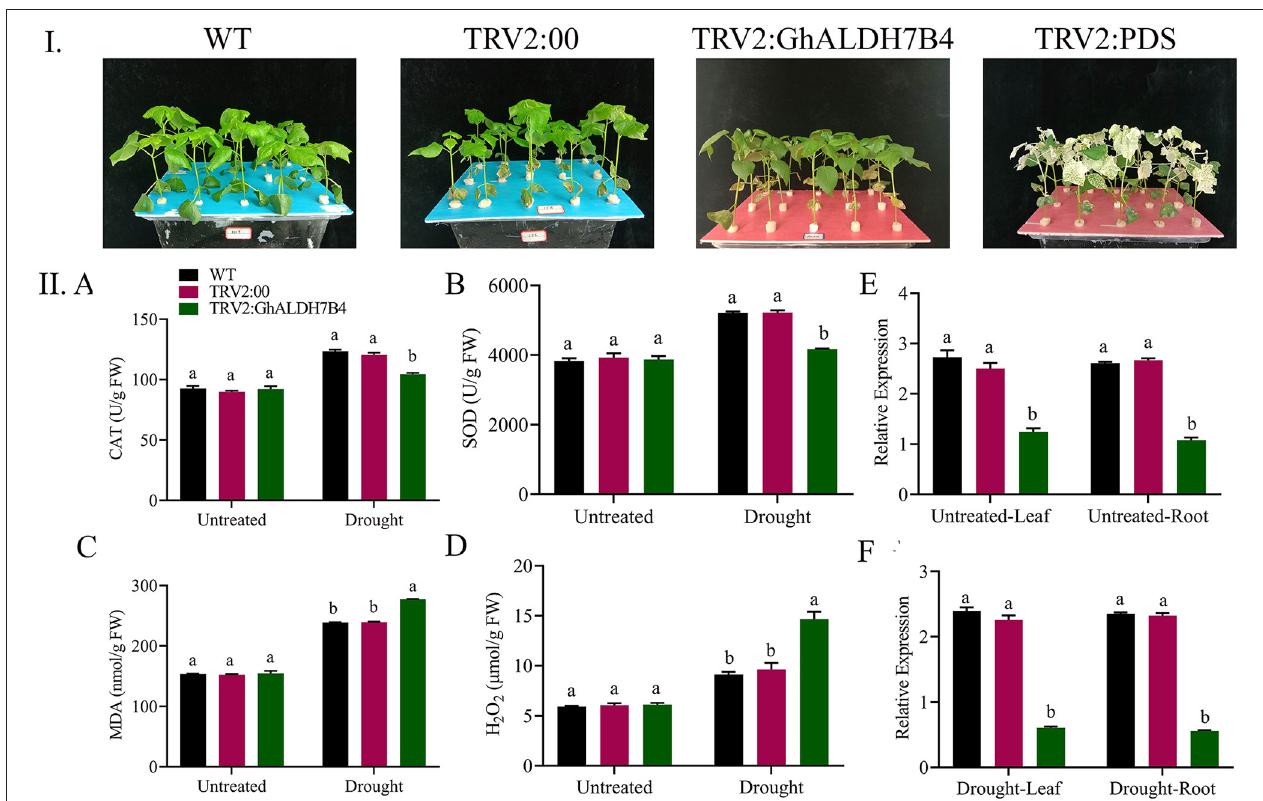
FIGURE 10 | Enzyme assay and analysis of the variation in the expression levels of cotton using RT-qPCR. (I) Illustrative pictures of Wildtype, TRV2:00, TRV2: GhALDH7B4 and TRV2: PDS. (II) A Catalase, B super oxidase, C malondialdehyde, D hydrogen peroxide, E stress response gene profile in wildtype, positive control, and silenced seedlings under drought stress in the leaves. F Stress response gene profile in wildtype, positive control, and silenced seedlings under drought stress in root tissue. The error bars reflect the SE. Using the Least Significant Difference (LSD), means on the same graph, with the same letter are not significantly different at the 5% probability level. Untreated: Control, Drought: supplementing with 17% PEG-6000 solution. SE, standard error; LSD, least significant